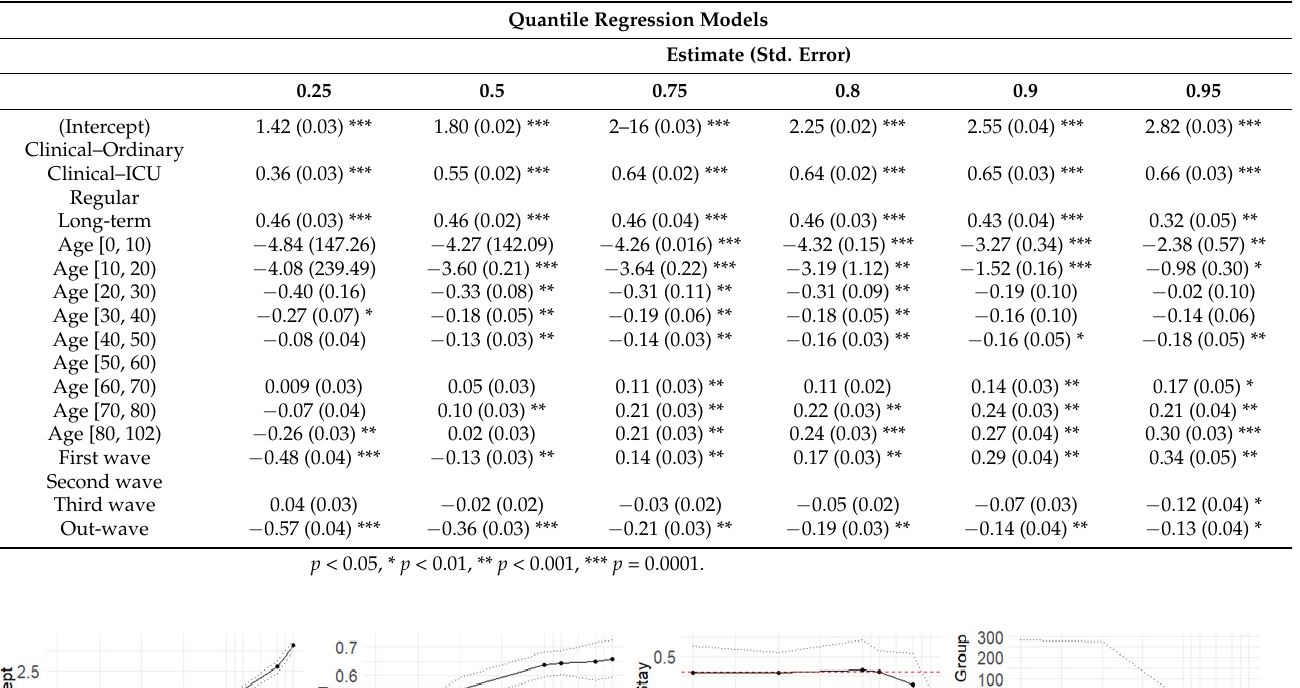
Table 7. Quantile regression models for count data.